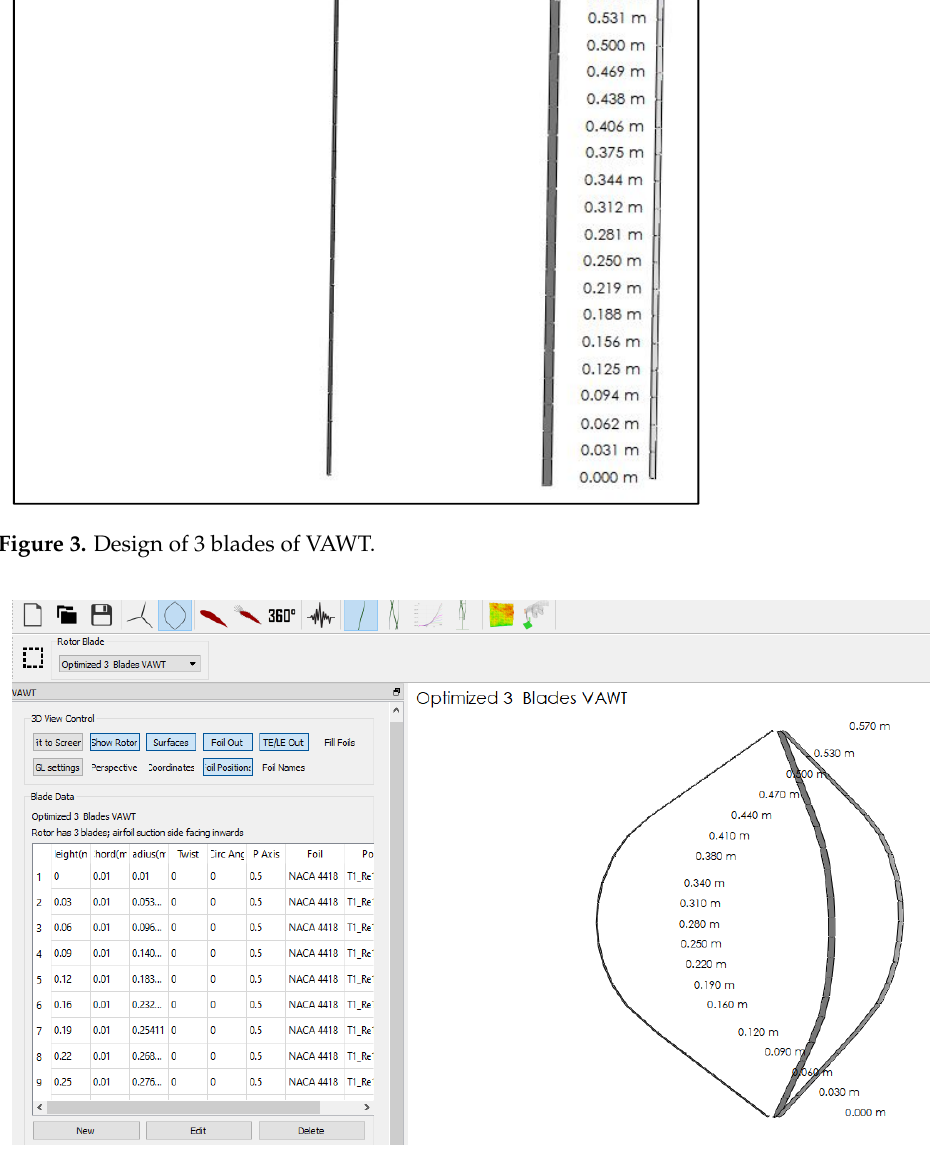
Figure 4. The details of the blade optimization process.